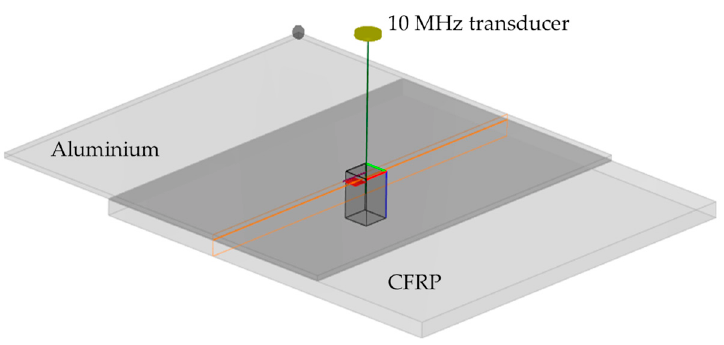
Figure 2. Ultrasonic pulse echo inspection simulation set-up of the sample of single-lap joint. The resulting B-scans of three different options of defect location—between alumi- num/adhesive, in the middle of adhesive, and the adhesive/composite—are shown in Figure 3.